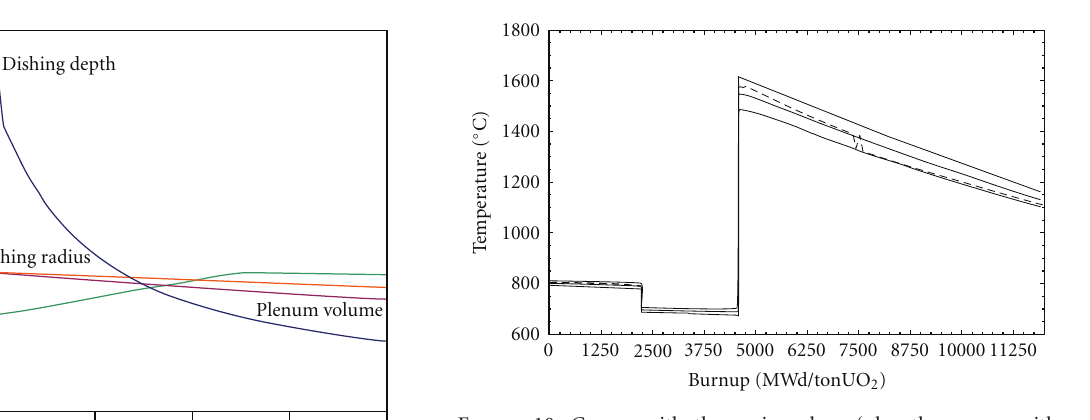
Figure 10: Curves with the main values (plus the curves with the main value ± its standard deviation). The dashed line is the standard calculation with nominal